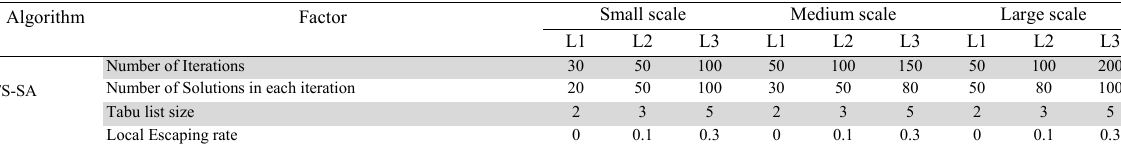
Initial estimation for levels of factors Algorithm